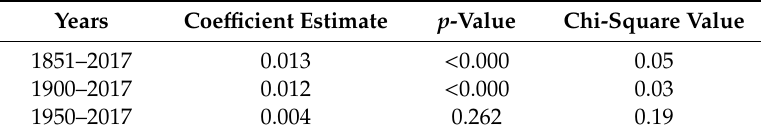
Table 7. Coefficient estimates, p-values, and chi-square p-values on the residual deviance for RI storms originating within the Gulf of Mexico sub-basin.